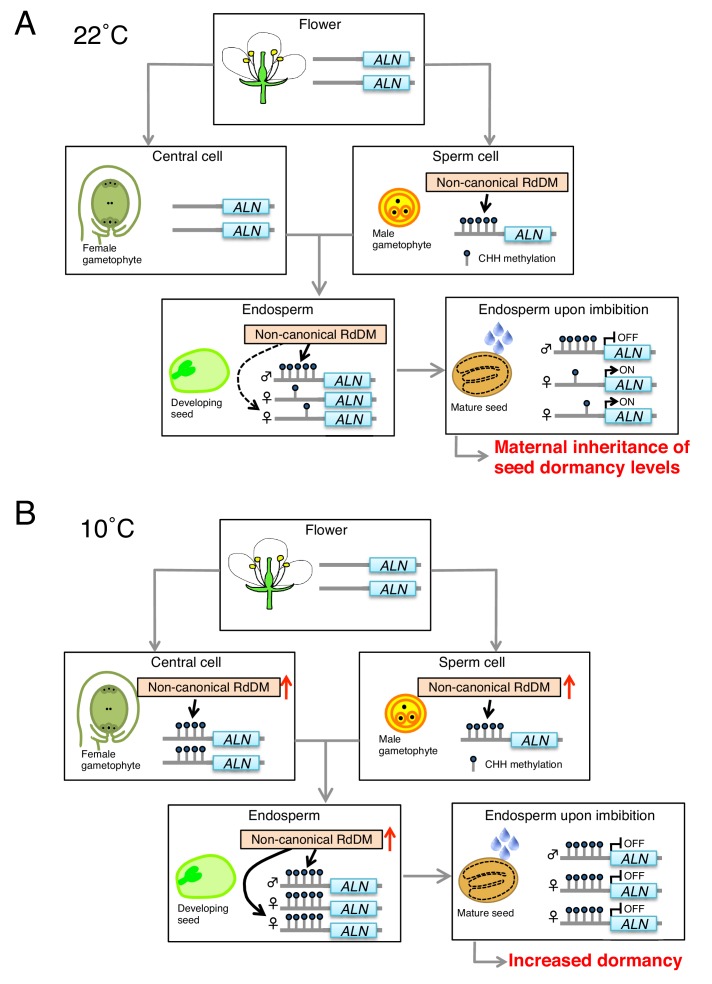
Model for parental and environmental control of seed dormancy through epigenetic control of ALN expression.(A) Under warm temperatures (22 ˚C), CHH methylation levels in the ALN promoter are lower in vegetative and flower tissues. During gametogenesis, CHH methylation is established in the sperm cells as a result of tissue-specific expression of AGO6, thus promoting non-canonical RdDM, which involves RDR2, RDR6, AGO6 and AGO4 components but not Pol IV. The paternal allele CHH methylation is maintained during seed development, which is likely due to pollen- and seed-specific non-canonical RdDM activity. (B) Under cold temperatures (10 ˚C) AGO6 accumulation is stimulated in pre-fertilization ovular tissues, which can increase RDR6-RdDM-dependent maternal allele methylation of the POGO region upstream of ALN. Cold also enhances AGO6 accumulation in stamens and post-fertilization ovular tissues, which can further increase methylation of the POGO region in mature seeds. Suppression of ALN expression promotes seed dormancy.